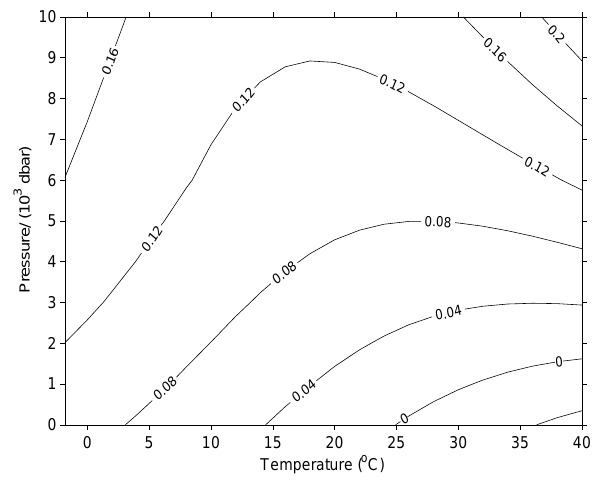
Fig. 1. The estimated density difference (gm − 3 , ppm) between two water samples used to represent NPIW and SSW that have been adjusted to give identical densities at t = 25 ◦ C and P = 101325Pa. These estimates are obtained using the FREZCHEM model and should be treated as rough estimates. However, even given the asso- ciated uncertainties, the differences are negligible compared to the total density changes associated with composition anomalies in the open